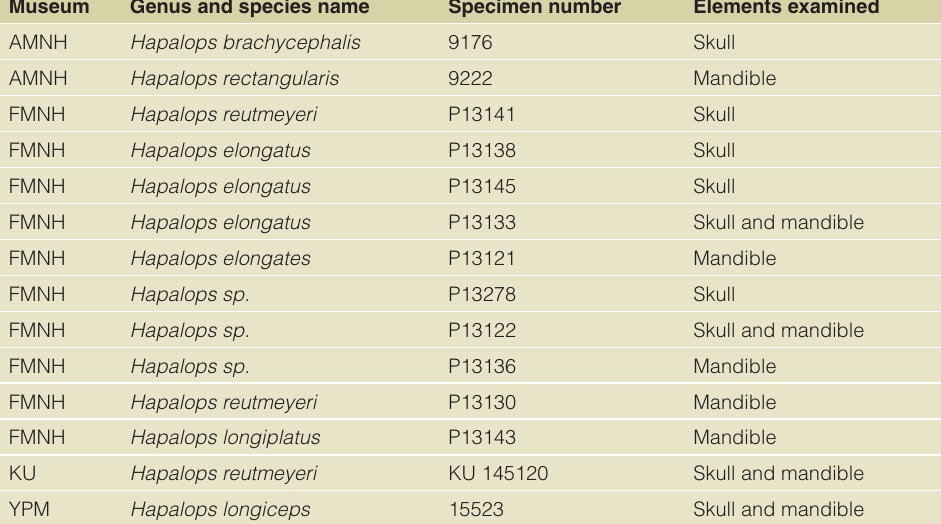
Table 1. Hapalops specimens examined for this study. The names of museums are represented by the following acronyms: American Museum of Natural History (AMNH), Field Museum of Natural History (FMNH) and University of Kansas Natural History Museum